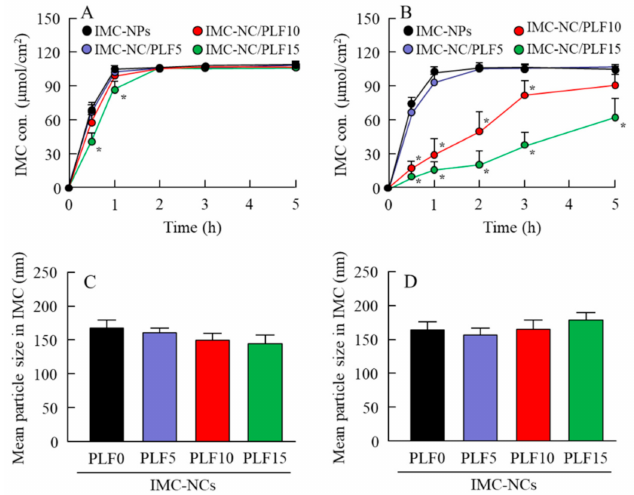
Figure 4. Di ff usion of IMC-NCs in each ophthalmic IMC-NC formulation through methacrylate cell. Di ff usion behavior of IMC-NCs in IMC-NPs, IMC-NC / PLF5, IMC-NC / PLF10, and IMC-NC / PLF15 at ( A ) 10 ◦ C and ( B ) 37 ◦ C. Mean particle size of IMC in reservoir chamber of methacrylate cell with each applied ophthalmic IMC-NC formulation at ( C ) 10 ◦ C and ( D ) 37 ◦ C. The compositions of each ophthalmic IMC-NC formulation are shown in Table 1; n = 8; * p < 0.05 vs. IMC-NPs for each category. The di ff usion of IMC-NCs decreased with PLF-127. In particular, the release of IMC-NCs from gelled IMC-NC / PLF10 and IMC-NC / PLF15 at 37 ◦ C was lower in comparison with IMC-NC without PLF-127